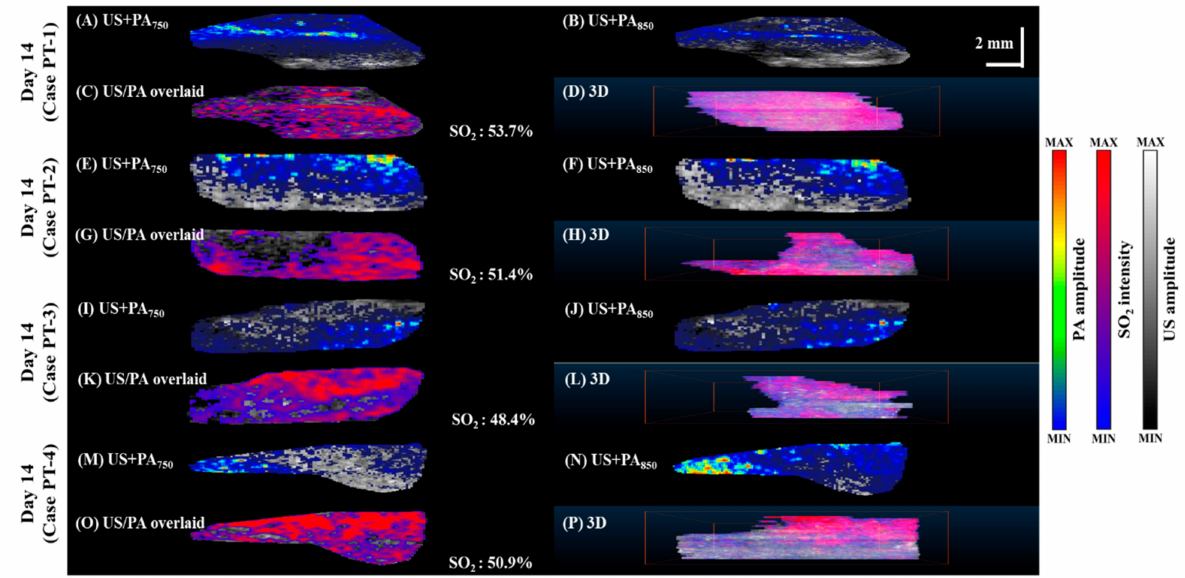
Figure 6. Relative SO 2 levels in pancreatic tumor in mice imaged 14 days after the tumor cell injection. ( A , E , I , M ) PA images acquired at 750 nm overlaid with grayscale US B-mode images. ( B , F , J , N ) PA images acquired at 850 nm overlaid with grayscale US B-mode images. ( C , G , K , O ) SO 2 was calculated as the percentage of oxygenated hemoglobin relative to total hemoglobin based on dual-wavelength PA imaging at 750 and 850 nm and overlaid with grayscale US B-scan images. ( D , H , L , P ) C-scan of SO 2 dynamics. Rotational 3D images can be seen in Supplementary Materials Video